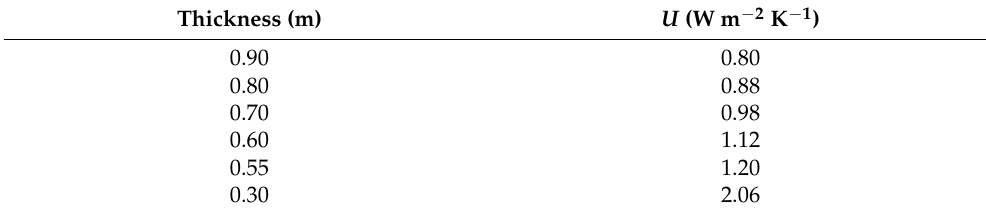
Table 3. U -values of all the walls of the